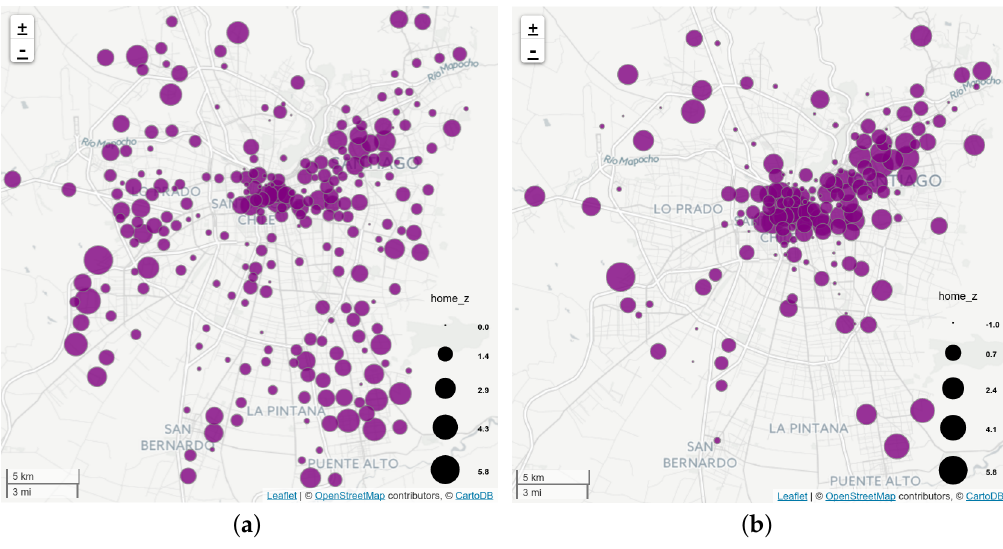
Figure 12. Zones from the city more likely to contain home ( a ) and work locations ( b ). The size of each bubble is proportional to the standard score of the population fraction detected to be within each zone for each